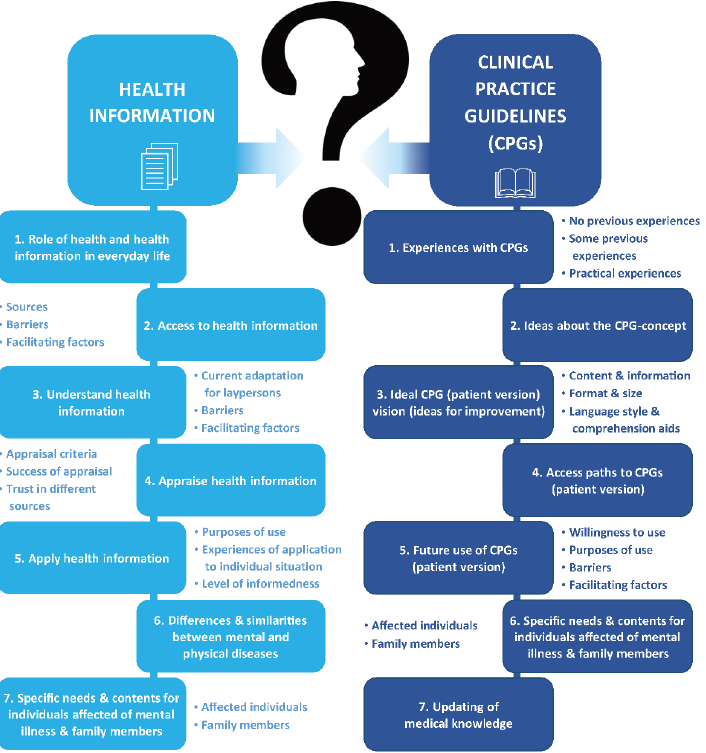
Figure 2. Thematic map of main categories, sub categories and (if applicable) sub themes identified in qualitative semi-structured interviews on patient health information and clinical practice guidelines with N = 15 individuals affected by mental illness and family members of affected adults.